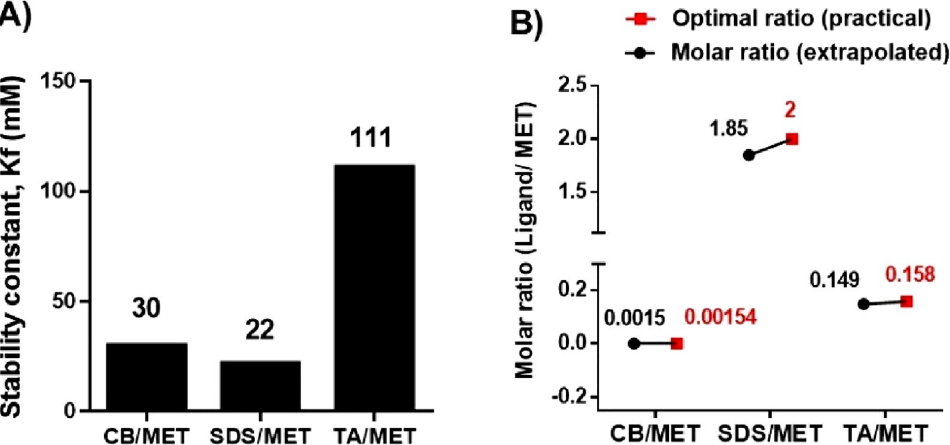
Figure 6. Stability constants and stoichiometric ratios of different MET complexes. ( A ) Estimated stability constants K f , and ( B ) stoichiometric ratios for Carbopol/metformin (CB/MET), Sodium dodecyl sulfate/MET (SDS/MET) and tannic acid /MET (TA/MET) complexes.